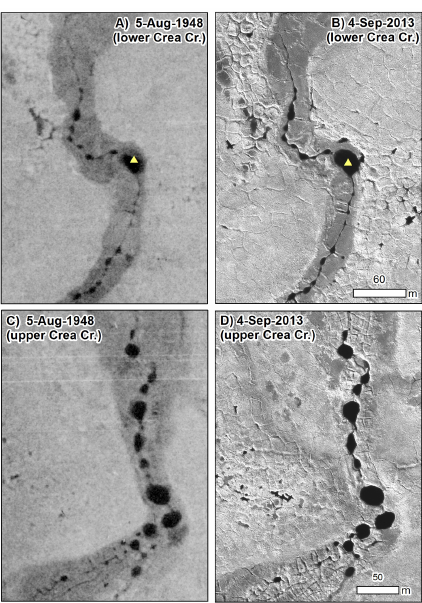
Figure 9. Comparison of two segments of the Crea Creek channel in 1948 (a, c) and 2013 (b, d) showing that pools, the riparian gulch, and adjacent thaw pits can be clearly observed in each image. The location of a sediment core collected for 14 C dating is indicated with a yellow triangle (location of Crea Creek is shown in Fig.